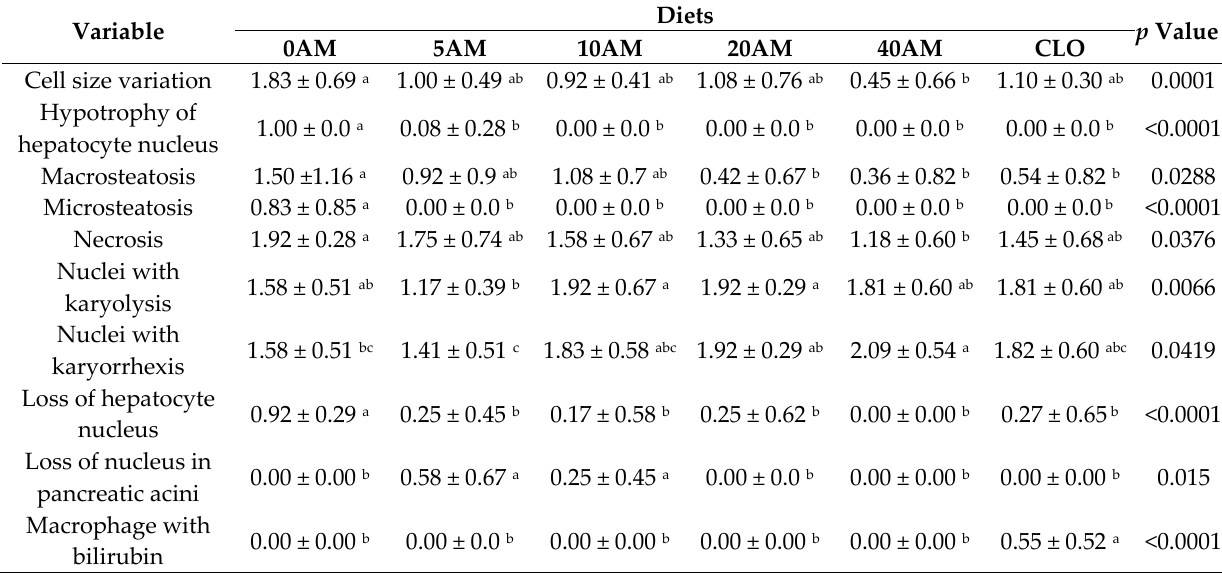
Table 10. Morphological alterations in hepatopancreas of Nile tilapia juveniles, when fed with increasing concentrations of Aurantiochytrium sp. meal (AM) or cod liver oil (CLO) for 87 days, at 22°C ¹.